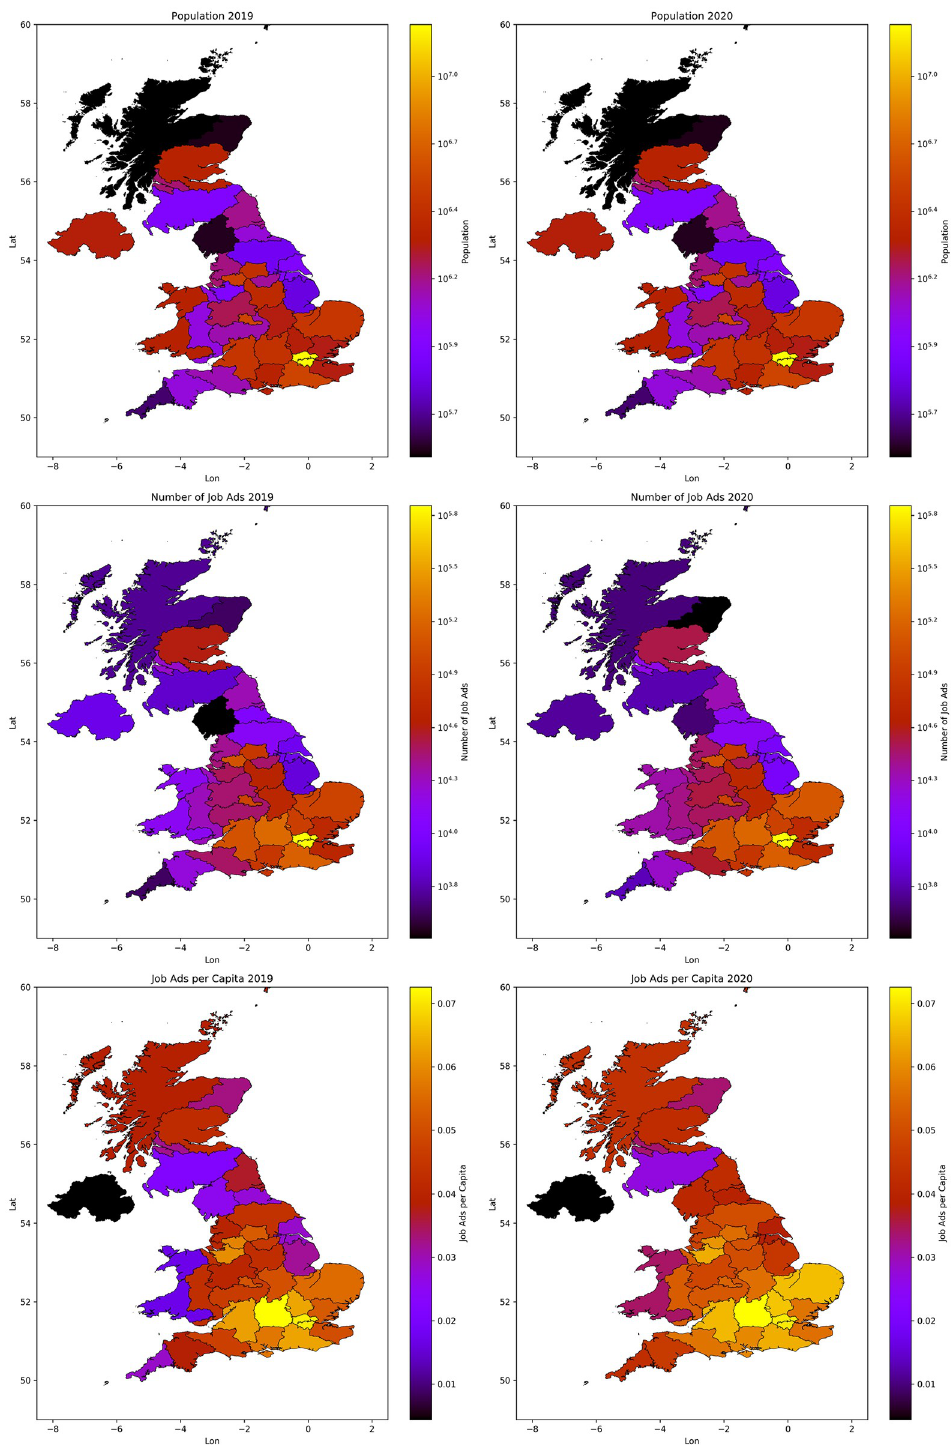
Fig 3. The administrative regions shown are the NUTS2 regions, except the London NUTS2 regions have been combined into ‘Greater London’. This is because a very large number of job ads give the location ‘London’, rather than a specific borough. The top row shows UK population, the middle shows the number of job ads posted and the bottom plot shows the number of job ads divided by the population of each region. The left column is 2019 and the right is 2020. Polygon boundary data is obtained from